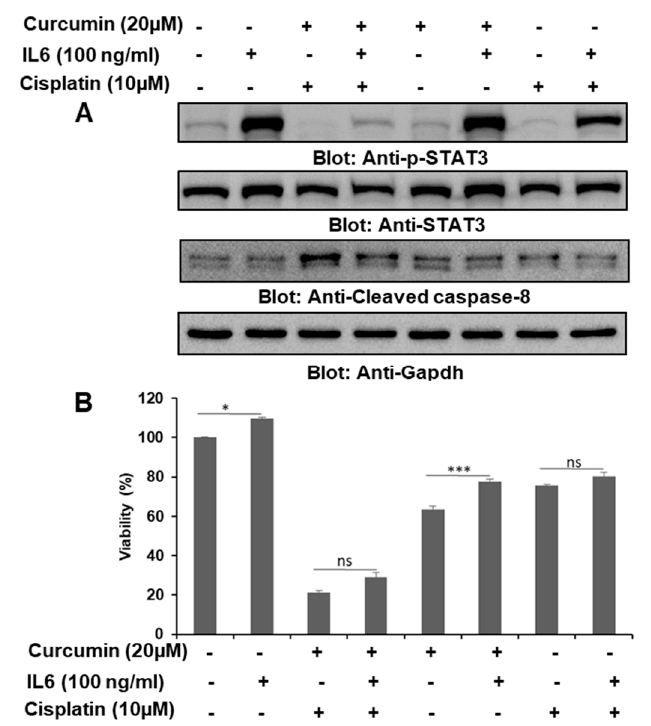
Figure 8. IL6 attenuated the curcumin- and cisplatin-induced inhibition of STAT3 and enhanced the proliferation of PTC cells. ( A ) BCPAP cells were treated with 0 μ M or 20 μ M of curcumin and 10 μ M of cisplatin alone and in combination in reduced serum-containing media, followed by IL6 (100 ng/mL) treatment. Cells were lysed and separated using SDS-PAGE, transferred to a PVDF membrane, and immunoblotted with antibodies such as p-STAT3, STAT3, cleaved caspase-8, and Gapdh. ( B ) IL6 stimulated the cell viability of BCPAP cells and protected cells from curcumin- and cisplatin-mediated inhibition of cell proliferation. BCPAP cells were stimulated with IL6 (100 ng/mL) and subsequently treated with curcumin and cisplatin, as indicated in Figure 2B, for 24 h. A cell proliferation assay was performed using a CCK8 kit, as described in the materials and methods section. Values are expressed as the mean +/ − the SD of at least six replicates, with a p -value of * p < 0.05, *** p < 0.001.